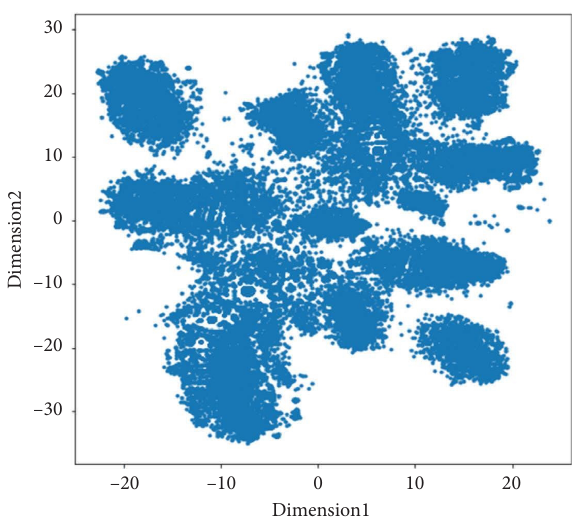
Figure 1: Two-dimensional representation of data using